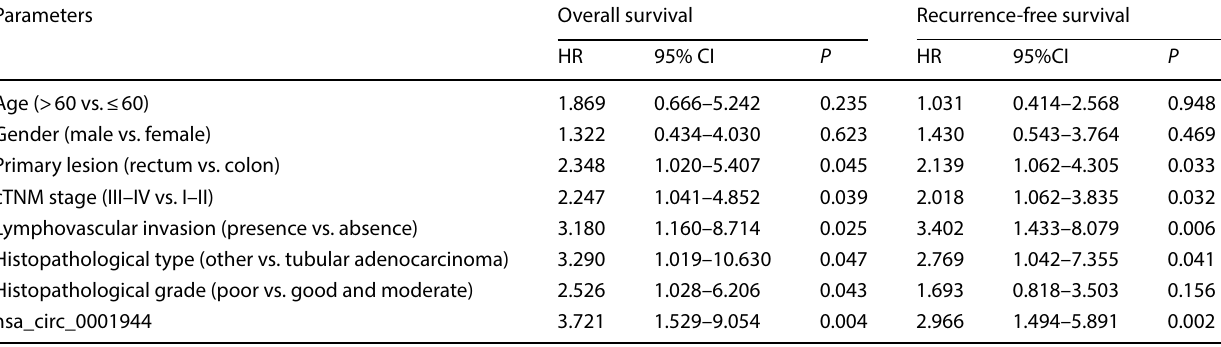
HR hazard ratios, CI